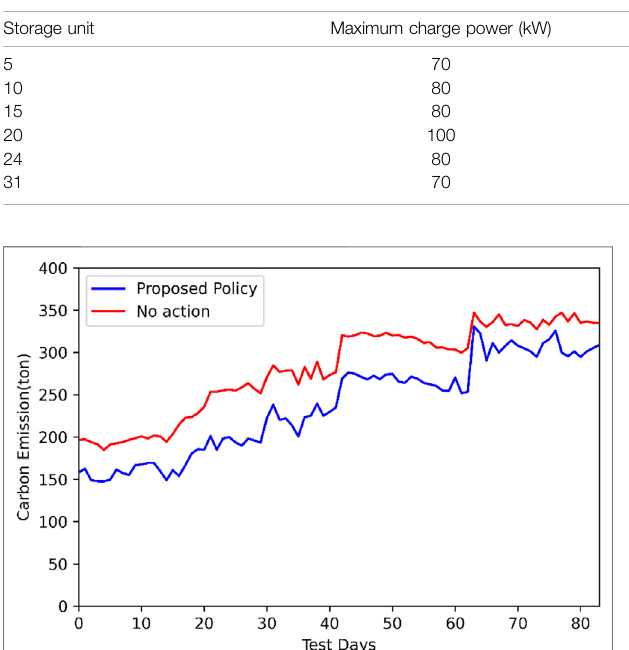
FIGURE 4 | Comparison of the proposed method and no action